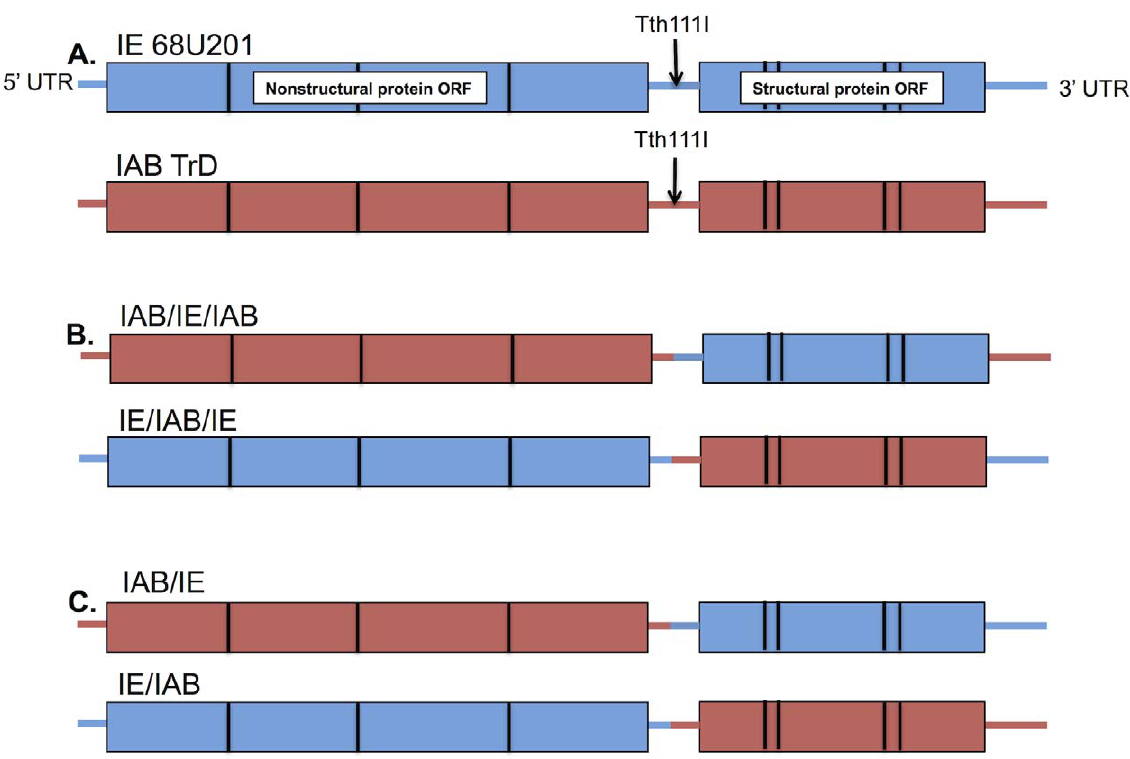
Figure 1. Schematic diagram of the virus strains utilized in this study. (A) The two parental viruses included strains IE 68U201 and IAB Trinidad Donkey (TrD). (B) IAB/IE/IAB and IE/IAB/IE were designed with matching cis -acting elements, which corresponded to the nonstructural protein opening reading frame (ORF) of the chimera. (C) IAB/IE and IE/IAB were designed with mismatched cis -acting elements, where the 3 9 UTR matched the strain used for the structural protein region of the chimera and the 5 9 UTR matched the strain used for the nonstructural protein region of the chimera. Tth111I indicates the location in which the two chimeric fusion fragments were joined by PCR.